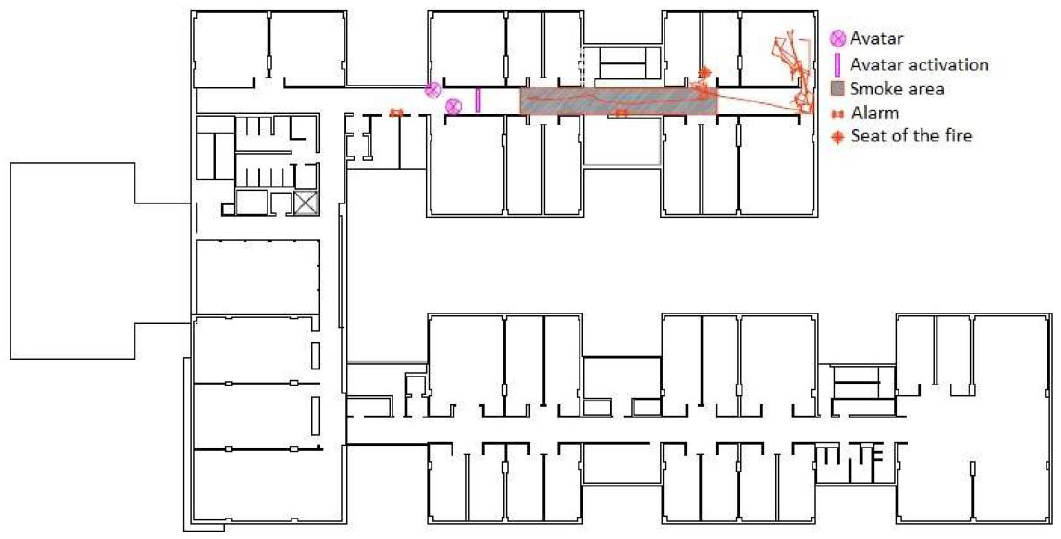
Figure 4. The red line shows the evacuation route.